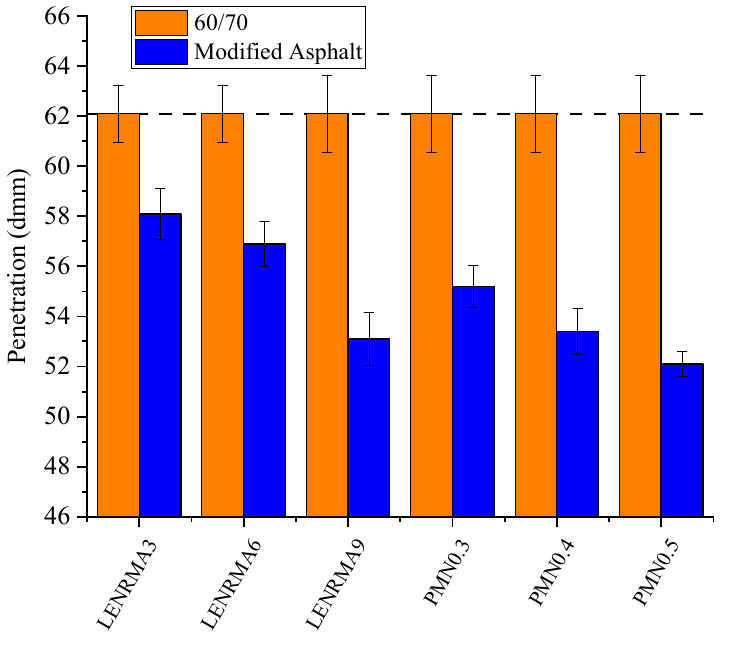
Figure 2. Penetration of all